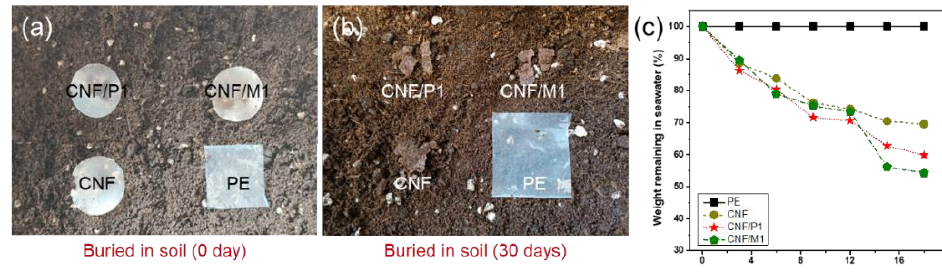
Figure 6. ( a , b ) The biodegradability test under moist soil for pure CNF, CNF/P1, CNF/M1, and PE films. ( c ) Effect of seawater immersion time on the weight remaining of pure CNF, CNF/P1, CNF/M1, and PE films.